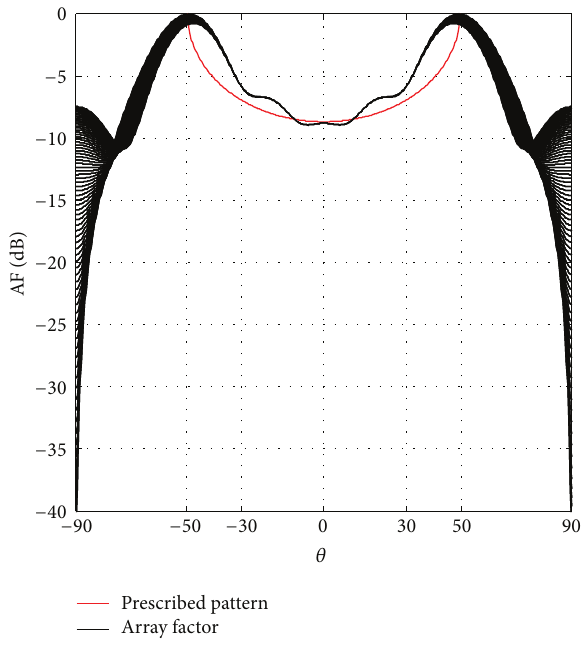
Figure 5: Isoflux radiation for LEO satellites with concentric